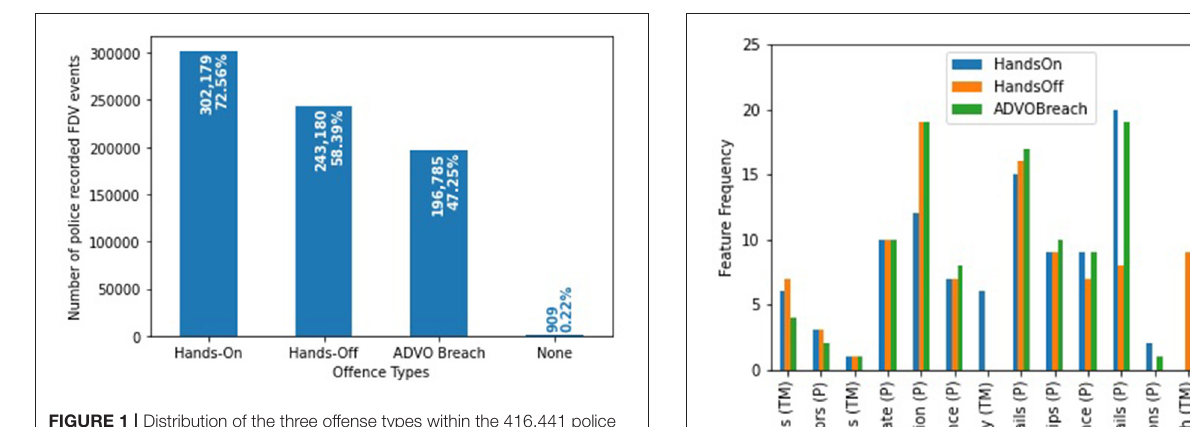
FIGURE 1 | Distribution of the three offense types within the 416,441 police recorded FDV events.